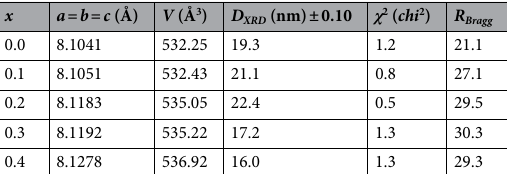
Table 1. Refined cell parameters of V x -MnCo (x ≤ 0.4)